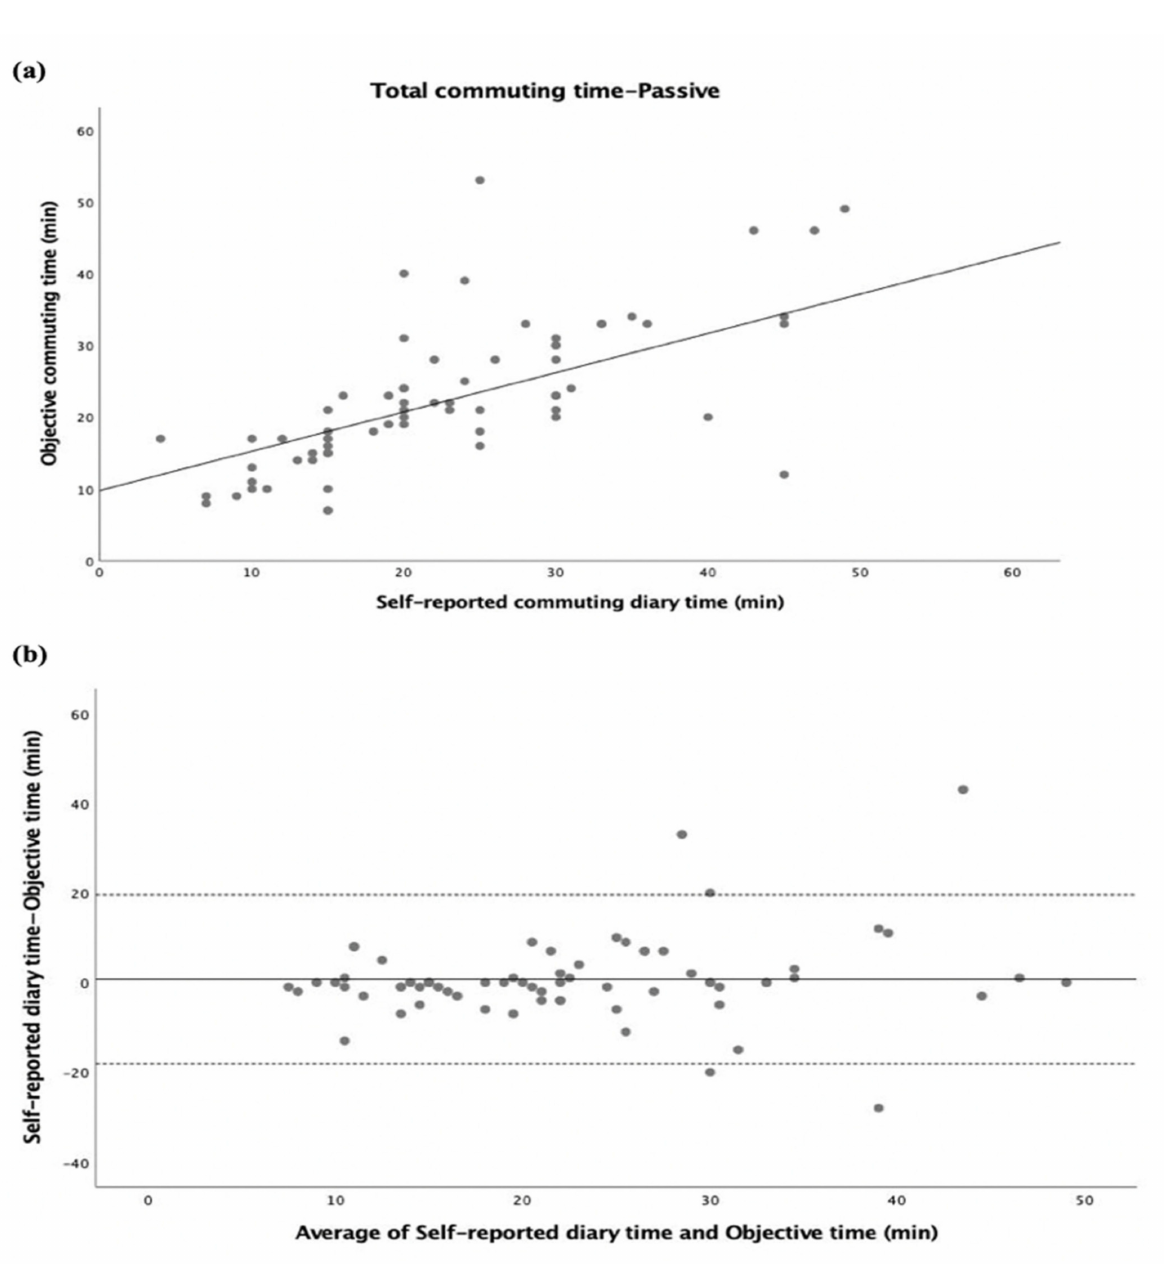
Figure 2. Commuting time expressed as minutes (total commuting time-passive). ( a ) Regression of the objective commuting time (y) vs. (x) the self-reported commuting diary time. The regression equation is y = 9.8 + 0.55x. ( b ) Bland–Altman plot of the total commuting time between self-reported diary time and objective time (y) vs. average of self-reported diary time and objective time (x). The central dotted line represents the mean of the differences between the objective time measure and the self-reported time measure; the upper and lower dotted lines represent the upper and lower 95% limits of agreement (mean differences + 1.96 standard deviations of the differences), respectively. Adolescents reported 3.86 min less in the total commuting time than the objective time (95% limits of agreement were 29.56 min and − 21.84